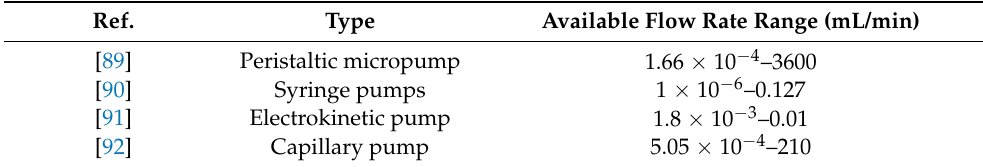
Table 2. Different types of micropumps.